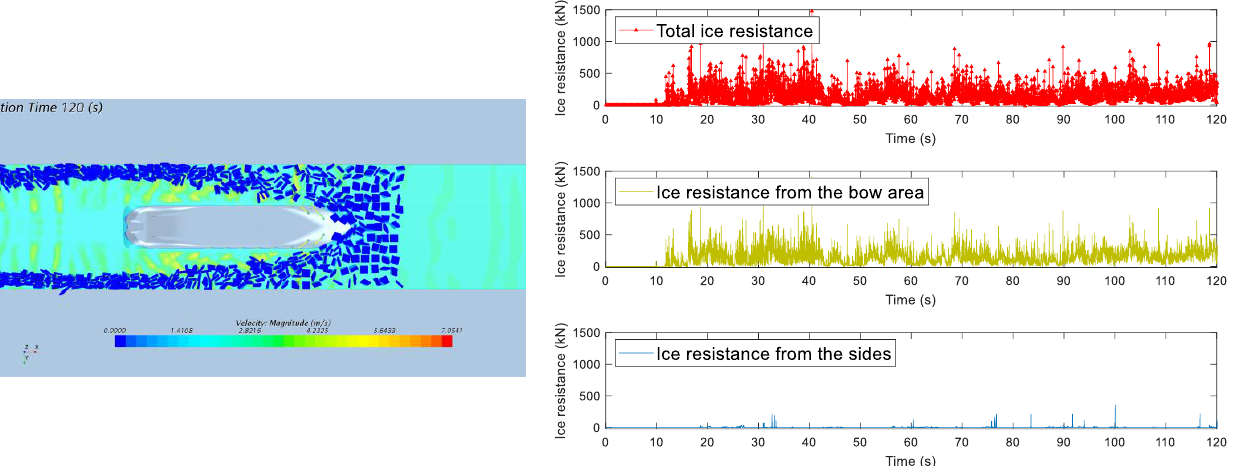
Figure 14. simulation and ice resistance of Case B: the side-nozzle ventilation rate is kept as 1 m/s; the bow nozzles are turned on as 1